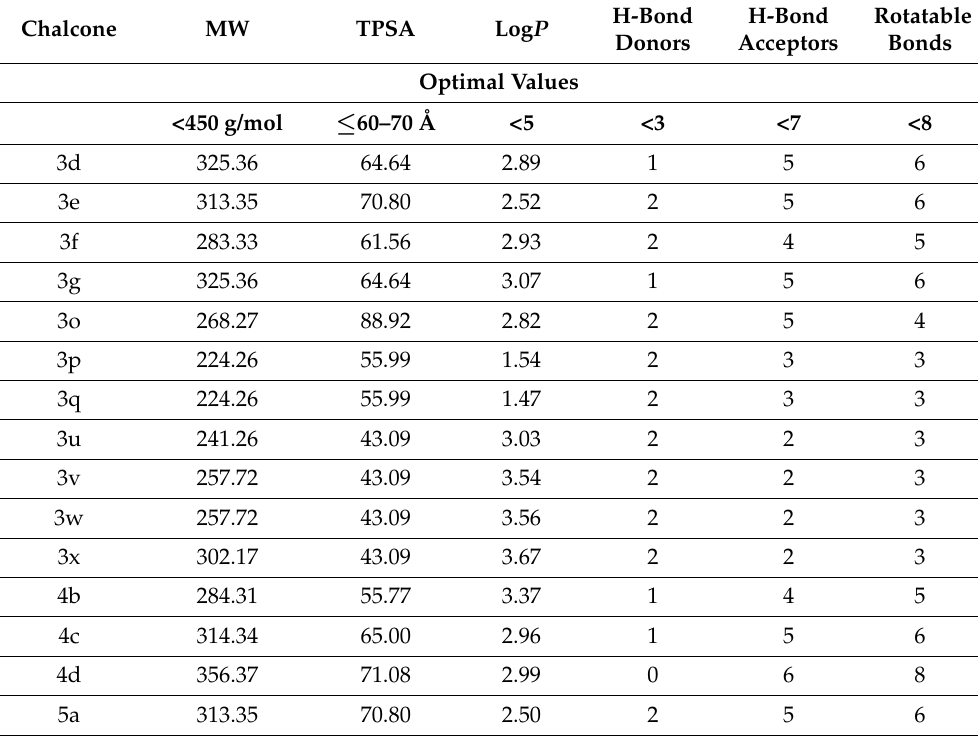
Table 3. Physiochemical properties relating to BBB crossing. Chalcone MW TPSA Log P